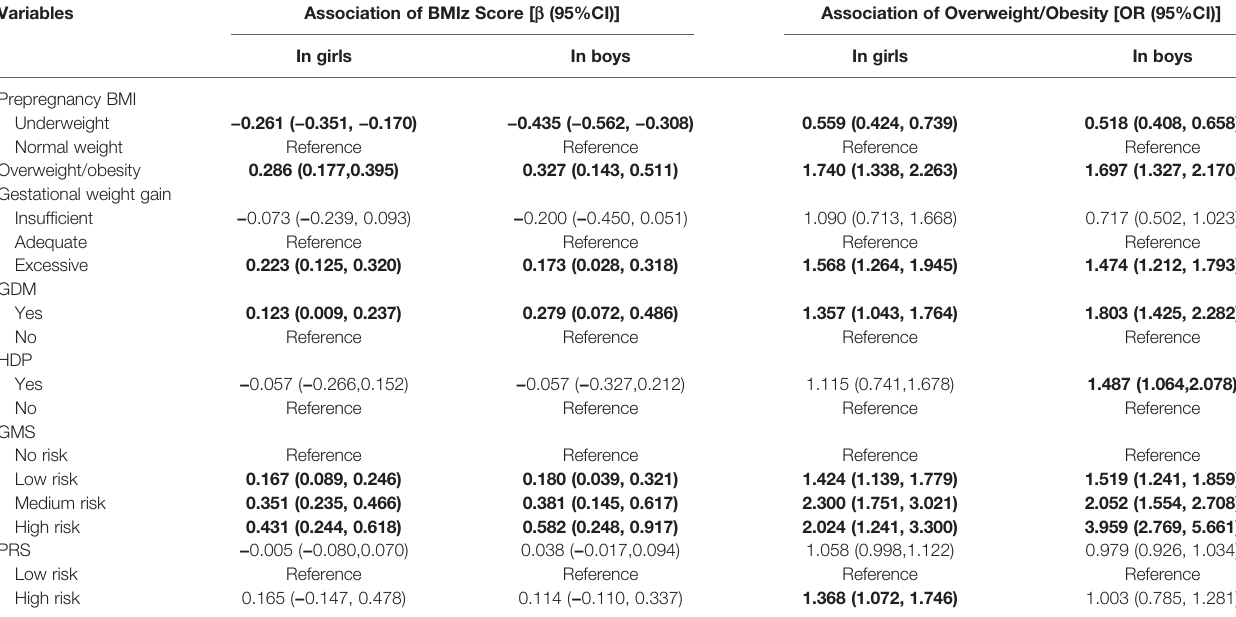
TABLE 2 | Association of gestational metabolic syndrome parameters with children ’ s BMIz scores and overweight/obesity using a generalized estimating equation.